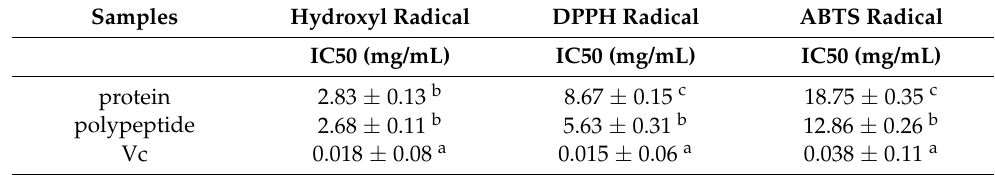
Table 7. IC 50 values of WBY protein, WBY polypeptide and Vc.